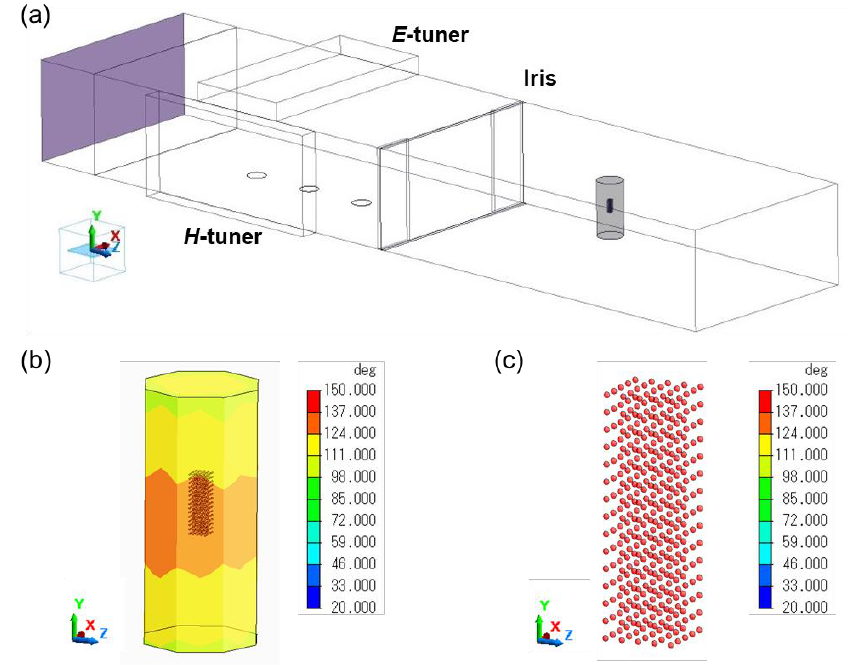
Figure 8. Cartoon images of ( a ) the microwave single-mode cavity, ( b ) the reactor containing activated carbon, and ( c ) the activated carbon particulates in the reactor used in the simulation.